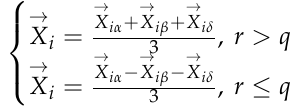
The populations of the beta ( )  and the delta ( )  are set to one or more, and F is the varia- tion factor. It declines in line with the amount of iterations from 0.6 to 0.3. The entire grey wolf group may slip into the local optimum and lose the ability to perform global searches under the formula and formula update if the alpha ( )  , beta ( )  , and delta ( )  grey wolves are in the local optimum in the multimodal function. Hence, the conflict between candidate leaders and leaders can be employed to resolve the decline in optimization accuracy induced by this condition.